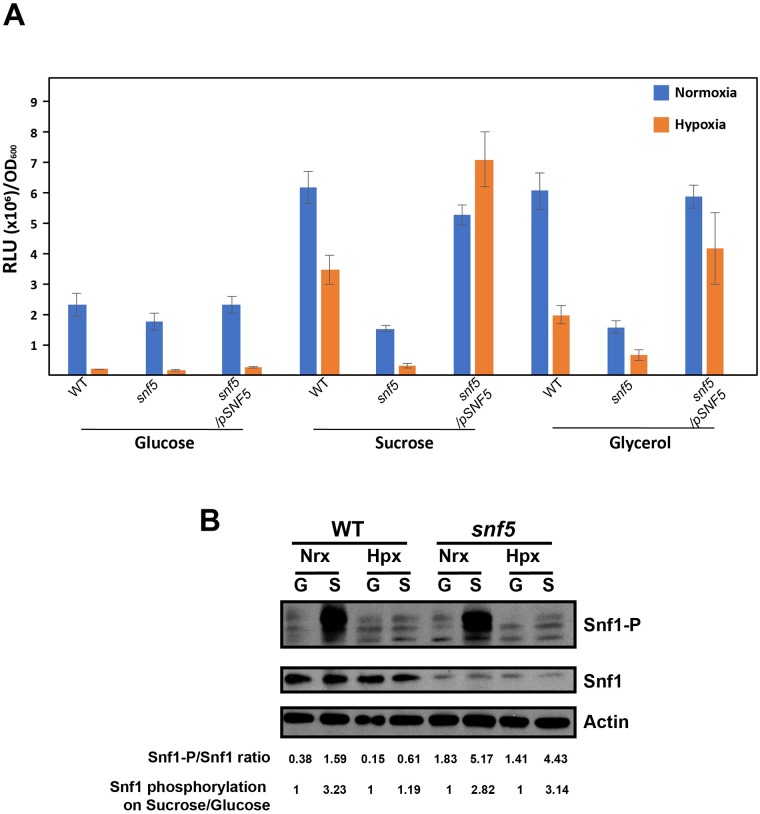
Snf5 is required to maintain ATP homeostasis associated with metabolic flexibility under hypoxia independently from the AMP-activated protein kinase Snf1.(A) Effect of hypoxia on cellular levels of ATP. ATP was quantified in the WT (SN250), snf5 mutant and the complemented strains by luminescence using the BacTiter-Glo reagent in liquid medium with different carbon sources (glucose, sucrose and glycerol) and oxygen status (21 and 5% O2). The presented results are from at least three independent experiments performed in triplicate. (B) Effect of hypoxia and carbon source quality on the phosphorylation of the AMP-activated protein kinase Snf1. Proteins were extracted from exponentially growing cells and were probed for Snf1, Snf1 phosphorylation (Snf1-P) and actin using AMPKAlpha, Phospho-AMPKAlpha (Thr172) and anti-actin antibodies. Relative Snf1 phosphorylation were indicated below the gel and were calculated as phosphorylation intensity of Snf1 (Snf1-P) divided by total Snf1 protein. Results were also indicated as the ratio of Snf1-P/total Snf1 as a percentage of the control value (measured in cells that grew on glucose).